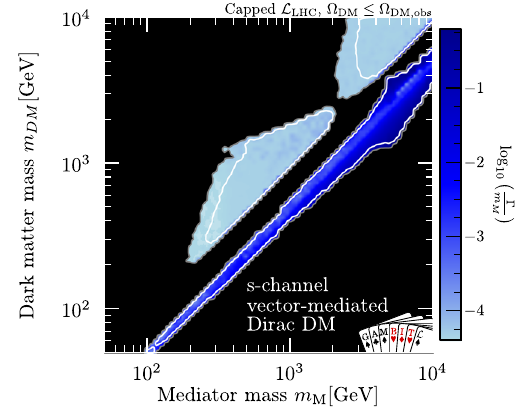
the dependence on mediator mass as it does not differ greatly from the dependence on DM mass. 1 σ and 2 σ contours are shown in white and grey respectively